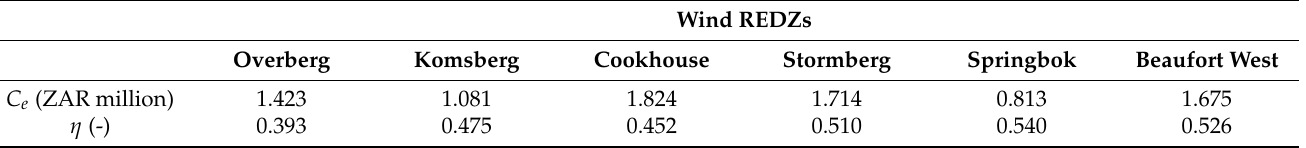
Table 11. Actual best solutions of cost of electricity and efficiency from NSGA-II for wind